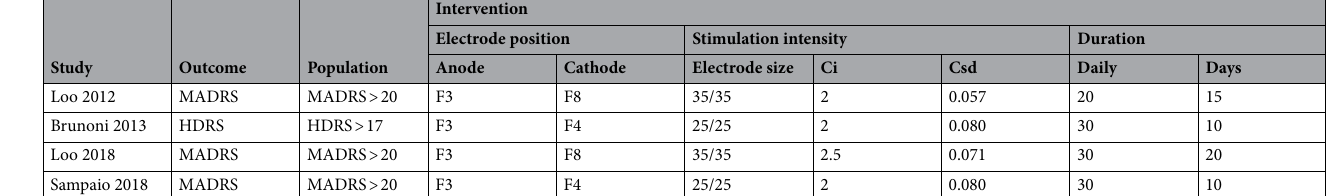
Table 6. Parameters. Depression. PICO variables for tDCS against depression. The parameters of tDCS intervention include the electrodes’ position (El position) expressed by the site of the 10–20 EEG International System where the electrode was centered; the stimulation intensity considering the area of the electrodes (El size, cm 2 ) for anode/cathode, the current intensity (Ci, mA), and the current superficial density (Csd, mA/ cm 2 ); the stimulation duration with the daily session duration (min) and the number of days (Days).